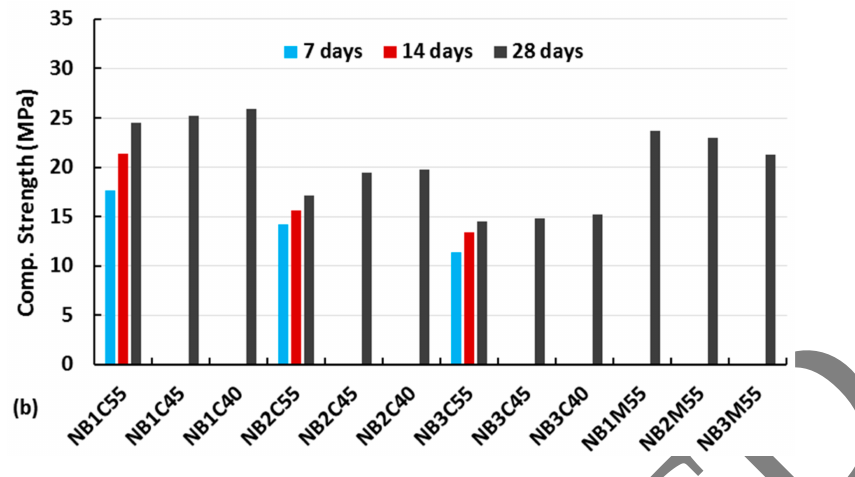
Figure 4. Ultimate compressive strength of ( a ) recycled brick concrete and ( b ) normal brick concrete at different ages.